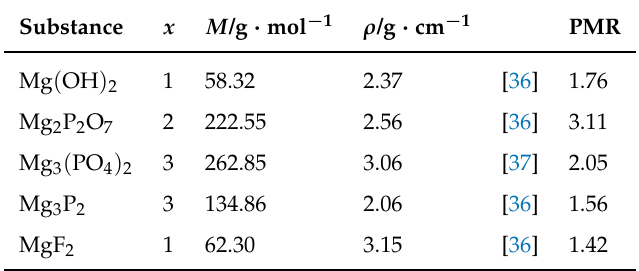
Table 4. PMRs and the material data necessary for their calculation for selected magnesium